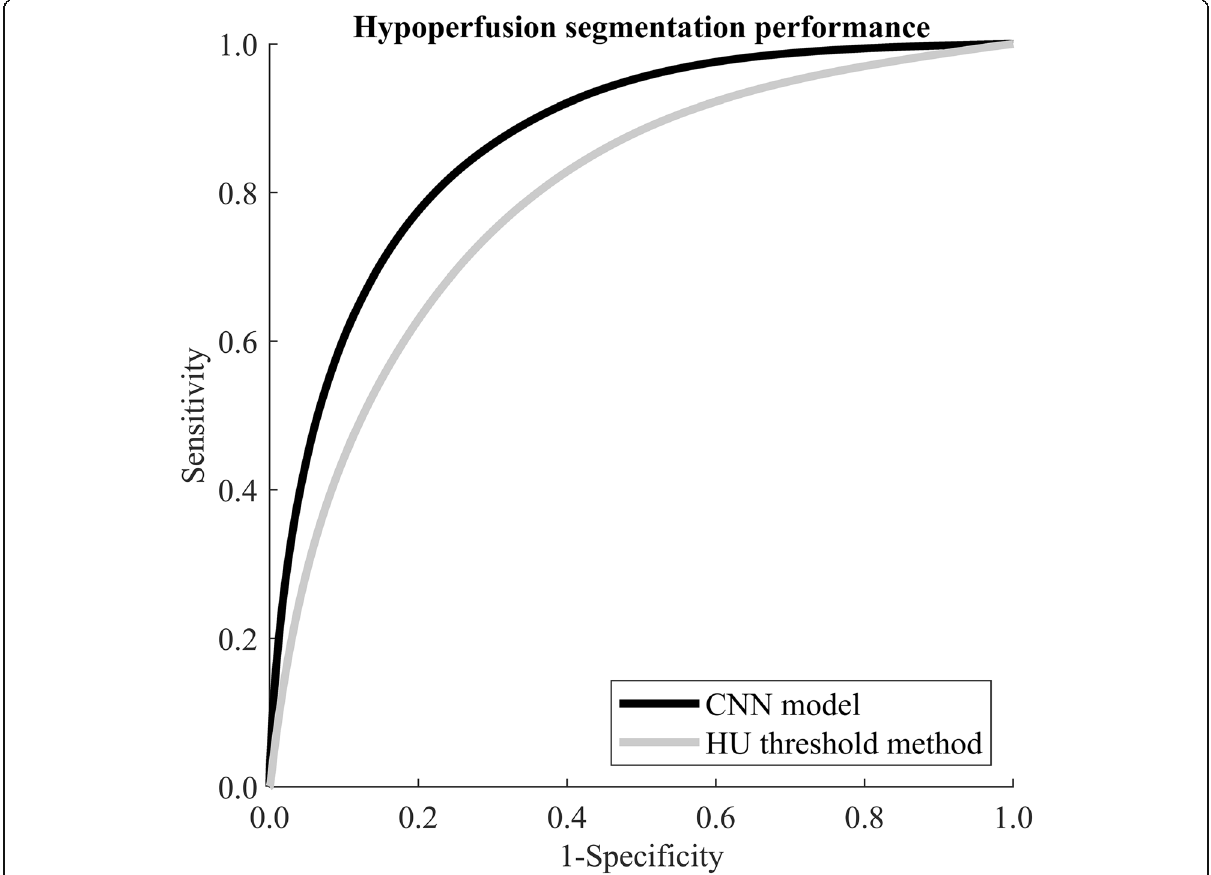
Fig 3 Receiver operating characteristic curves when applying the convolutional neural network (CNN) model or using a global naïve Hounsfield unit threshold method. The areas under the curves were 0.87 and 0.79, respectively. HU Hounsfield